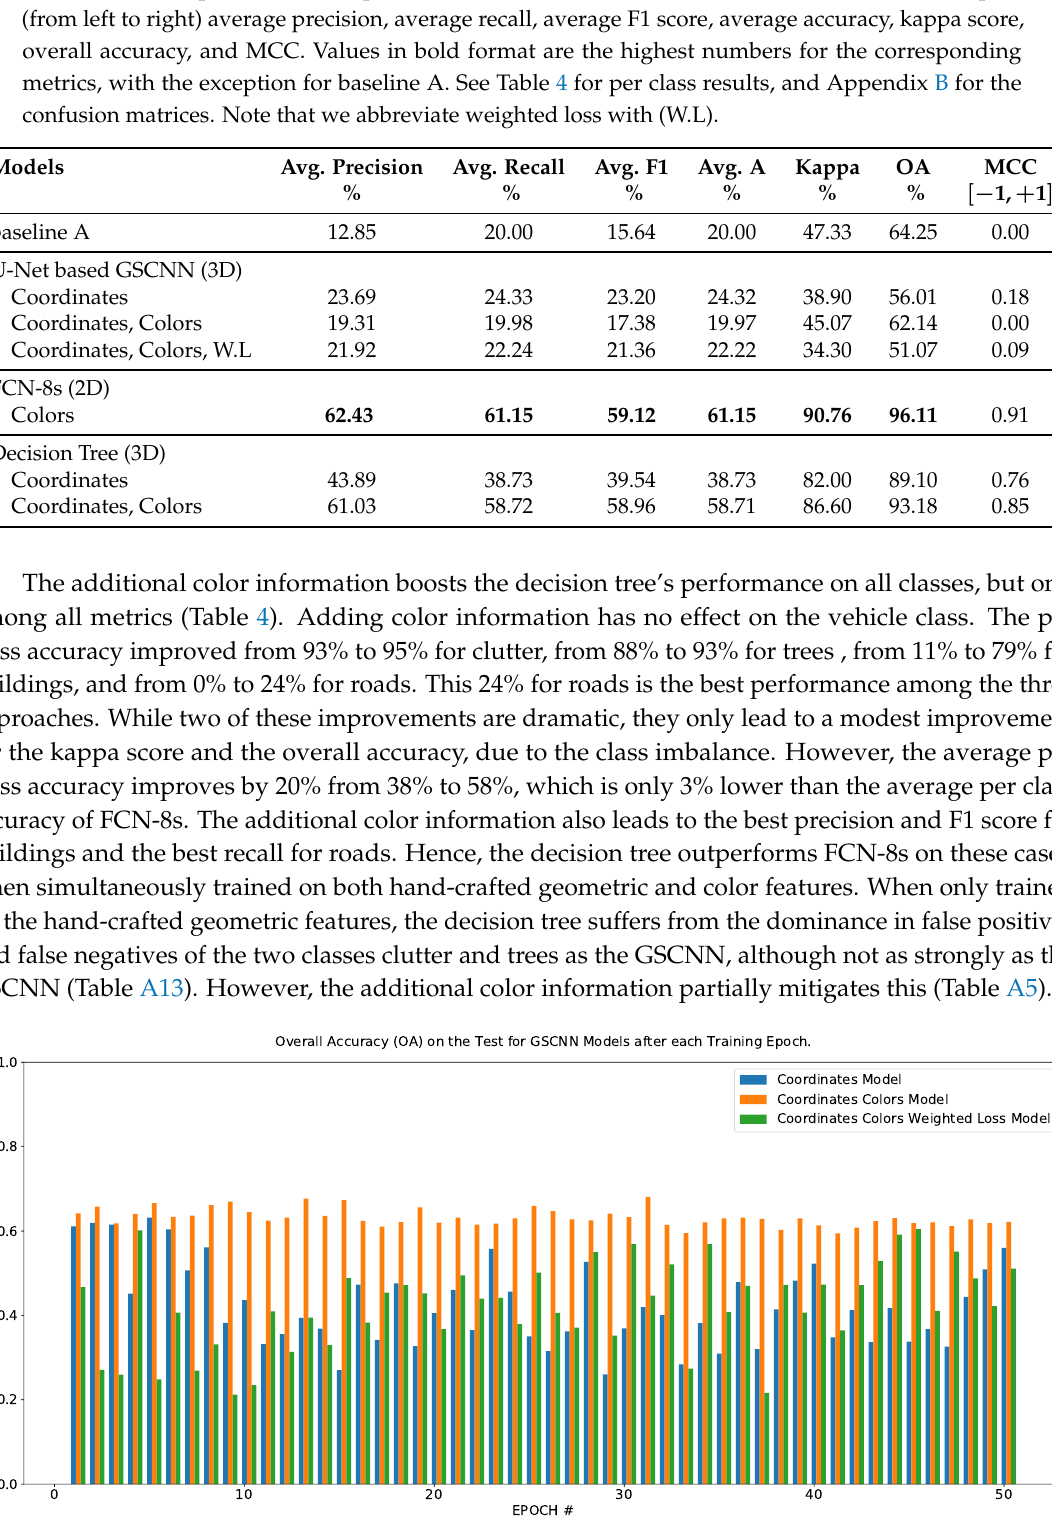
Figure 7. Overall accuracy for the GSCNN models after each